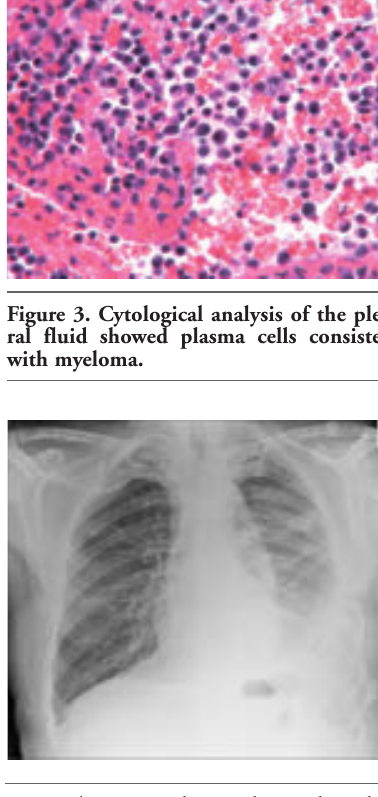
Figure 2. Computed tomography of the chest was radiologically suggestive of me - so thelioma.